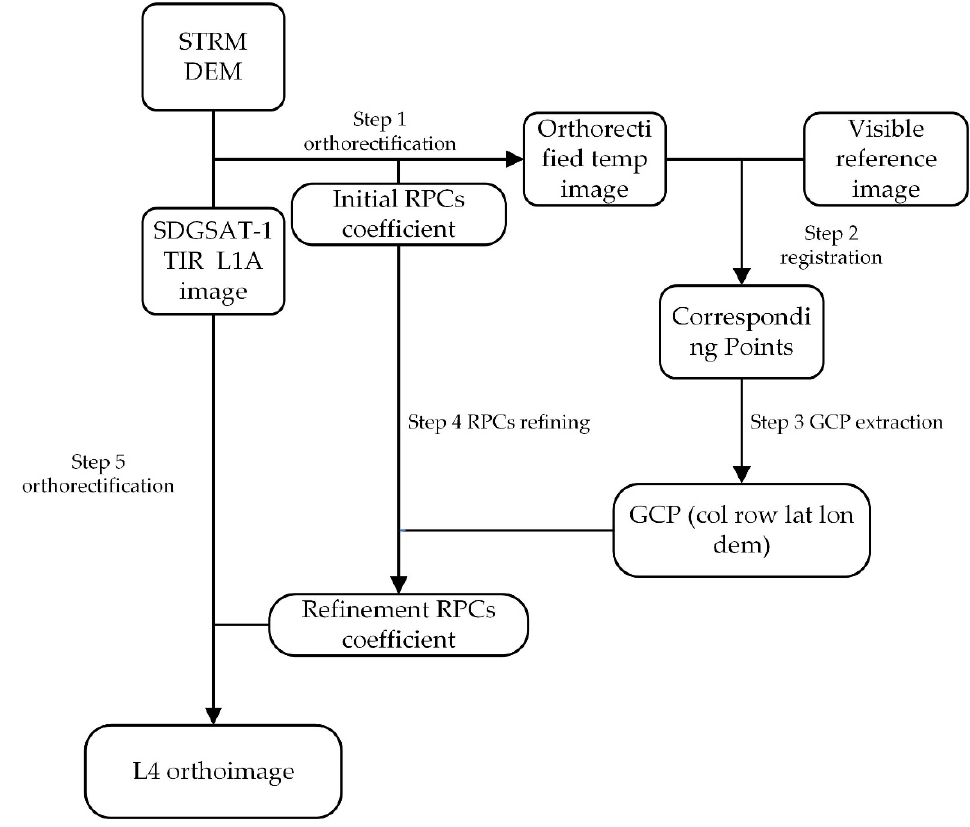
Figure 3. The two-step orthorectification process for SDGSAT-1 TIS image.